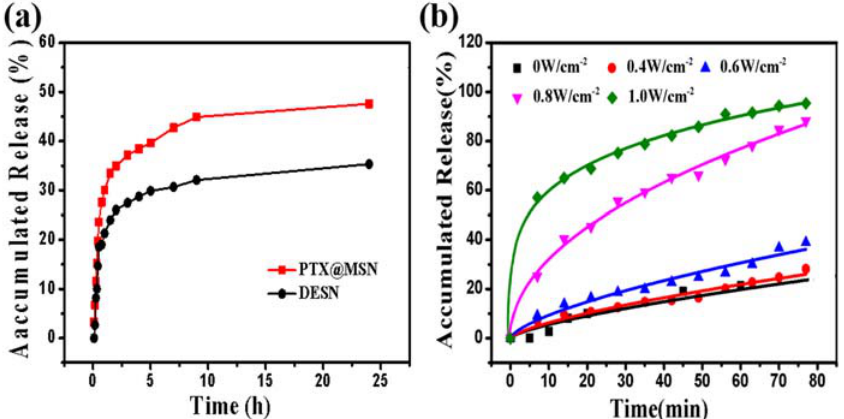
Figure 4. ( a ) The release profiles of PTX from MSN and DESN in PBS at pH 7.4; ( b ) the release profiles of PTX from DESN under LEUS with different intensities (1 MHz; 0, 0.4, 0.6, 0.8, and 1.0 W·cm − 2 ).